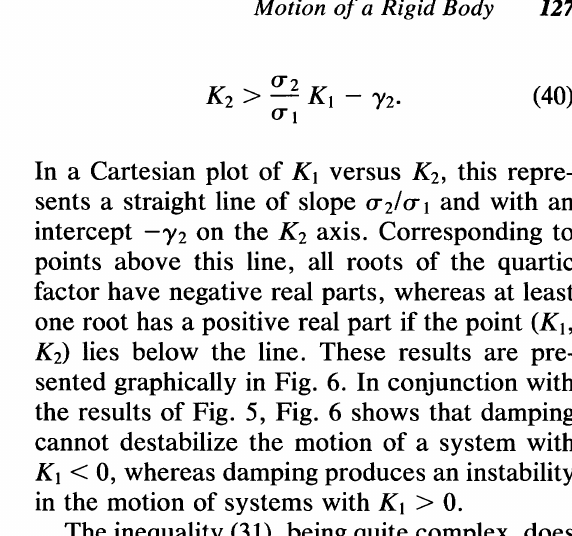
FIGURE 5 First of two instability charts for the sys tem.